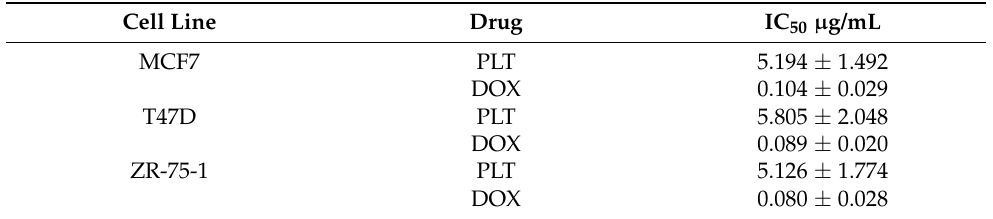
Table 1. The anti-proliferative effects of palmatine (PLT) and doxorubicin (DOX) administered singly in human breast cancer cell lines measured in vitro by the MTT assay. Data are